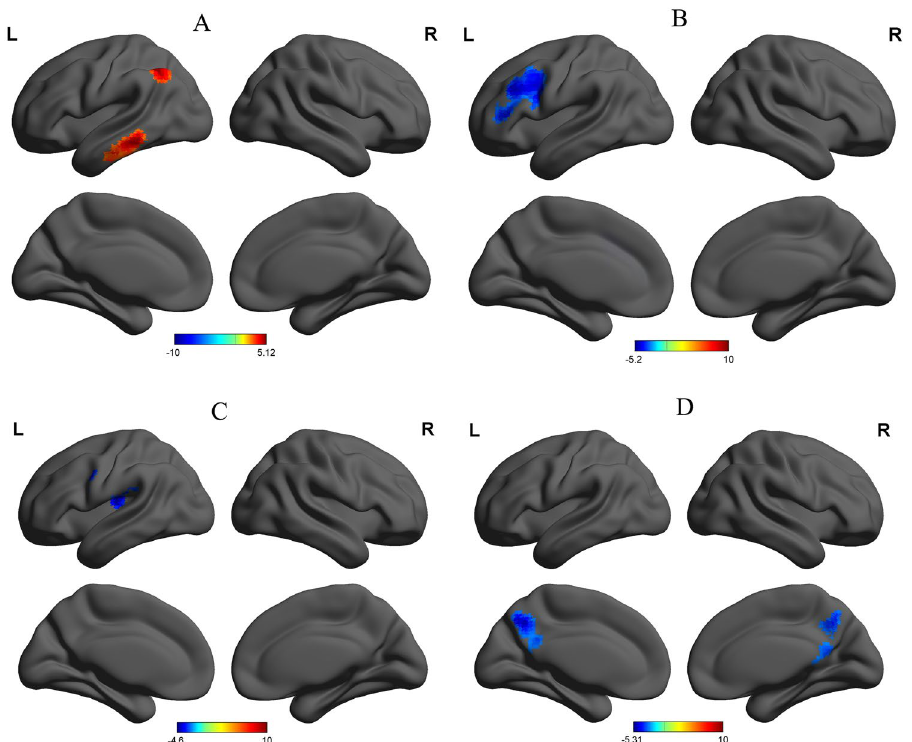
Figure 7. Seed-based functional connectivity differences for each region of interest between PIs and GSs. Note: Betweent-group differences in functional connectivity using the four ROIs that differ from binarized degree centrality, including right middle temporal gyrus ( A ), left middle temporal gyrus ( B ), right insula ( C ), and left superior frontal gyrus ( D ) with whole brain. Abbreviations: R, right; L, left; PIs, Patients with primary insomnia; GSs, Good sleepers; ROI, Region of interest.